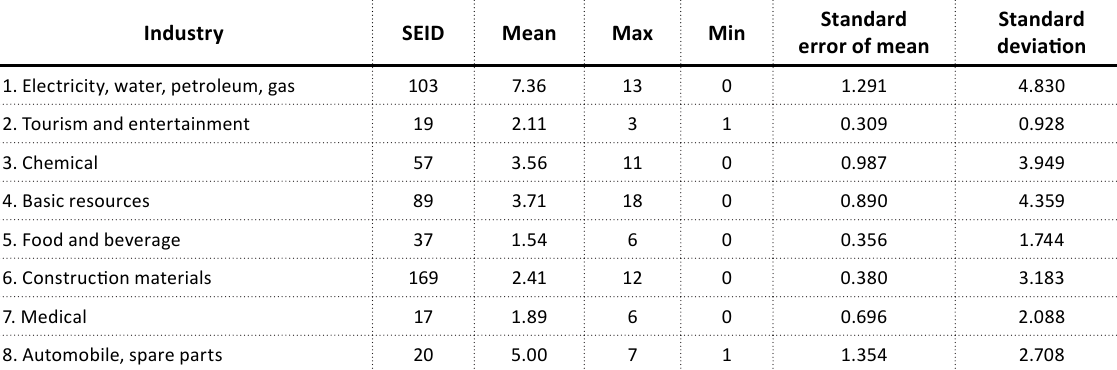
Source: Result of SPSS